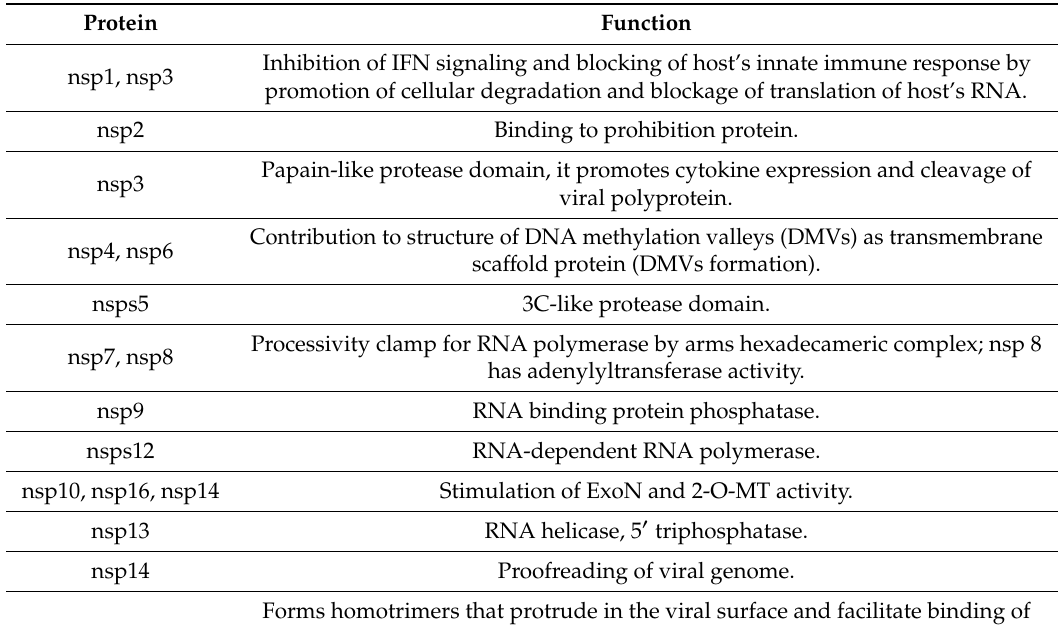
Table 1. Di ff erent proteins of coronaviruses and their functions